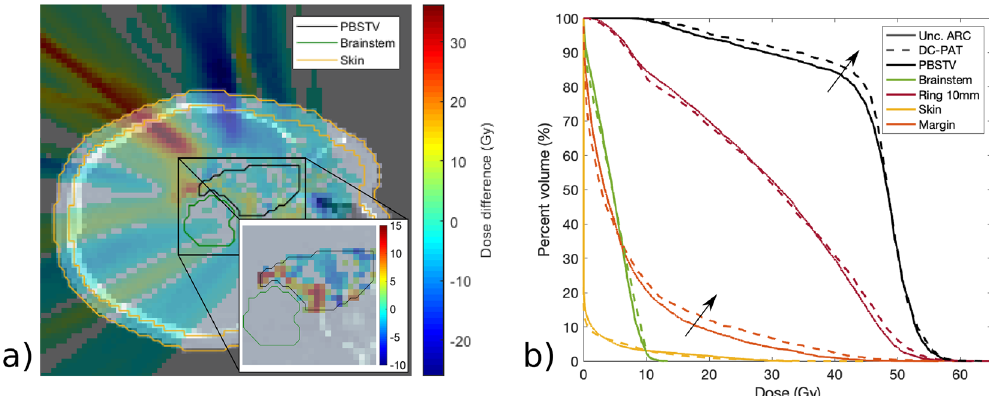
Figure 4. ( a ) Dose difference map between the DC-PAT and uncollimated arc PBS treatment plans treating a reduced target volume in order to spare the brainstem. A zoomed-in profile of the dose difference is shown for voxels within the pencil beam scanning target volume (PBSTV). A new structure referred to as the Margin was included within the DVH and is the portion of the PTV that is within 5mm of the brain stem contour. ( b ) DVH of the nearby structures is shown right. Each plan was optimized to achieve as much target coverage as possible while maintaining a nearly equivalent brainstem DVH.